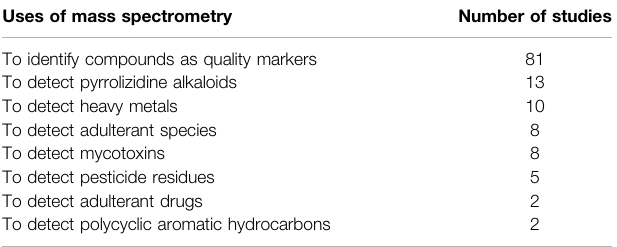
TABLE 4 | Uses of mass spectrometry in the analysis of herbal